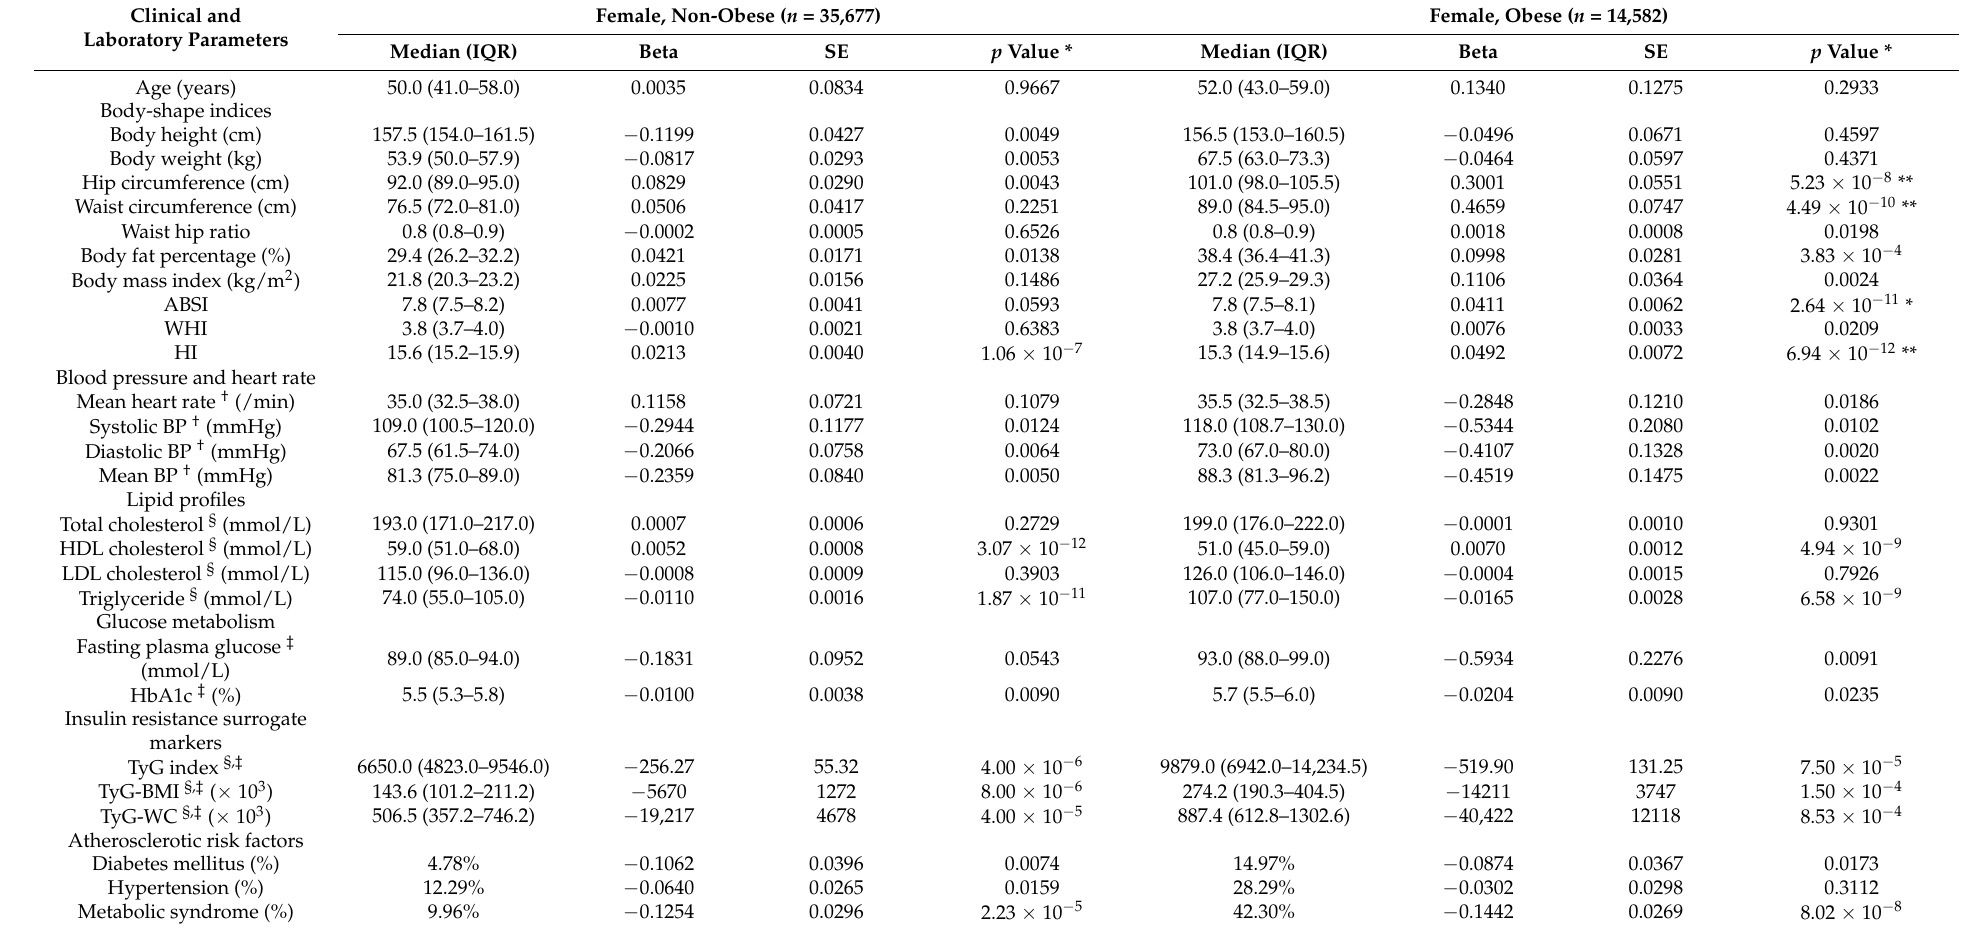
Table 3. Association between KLF14 rs4731702 genotype and body shape indices and metabolic traits according to obesity in